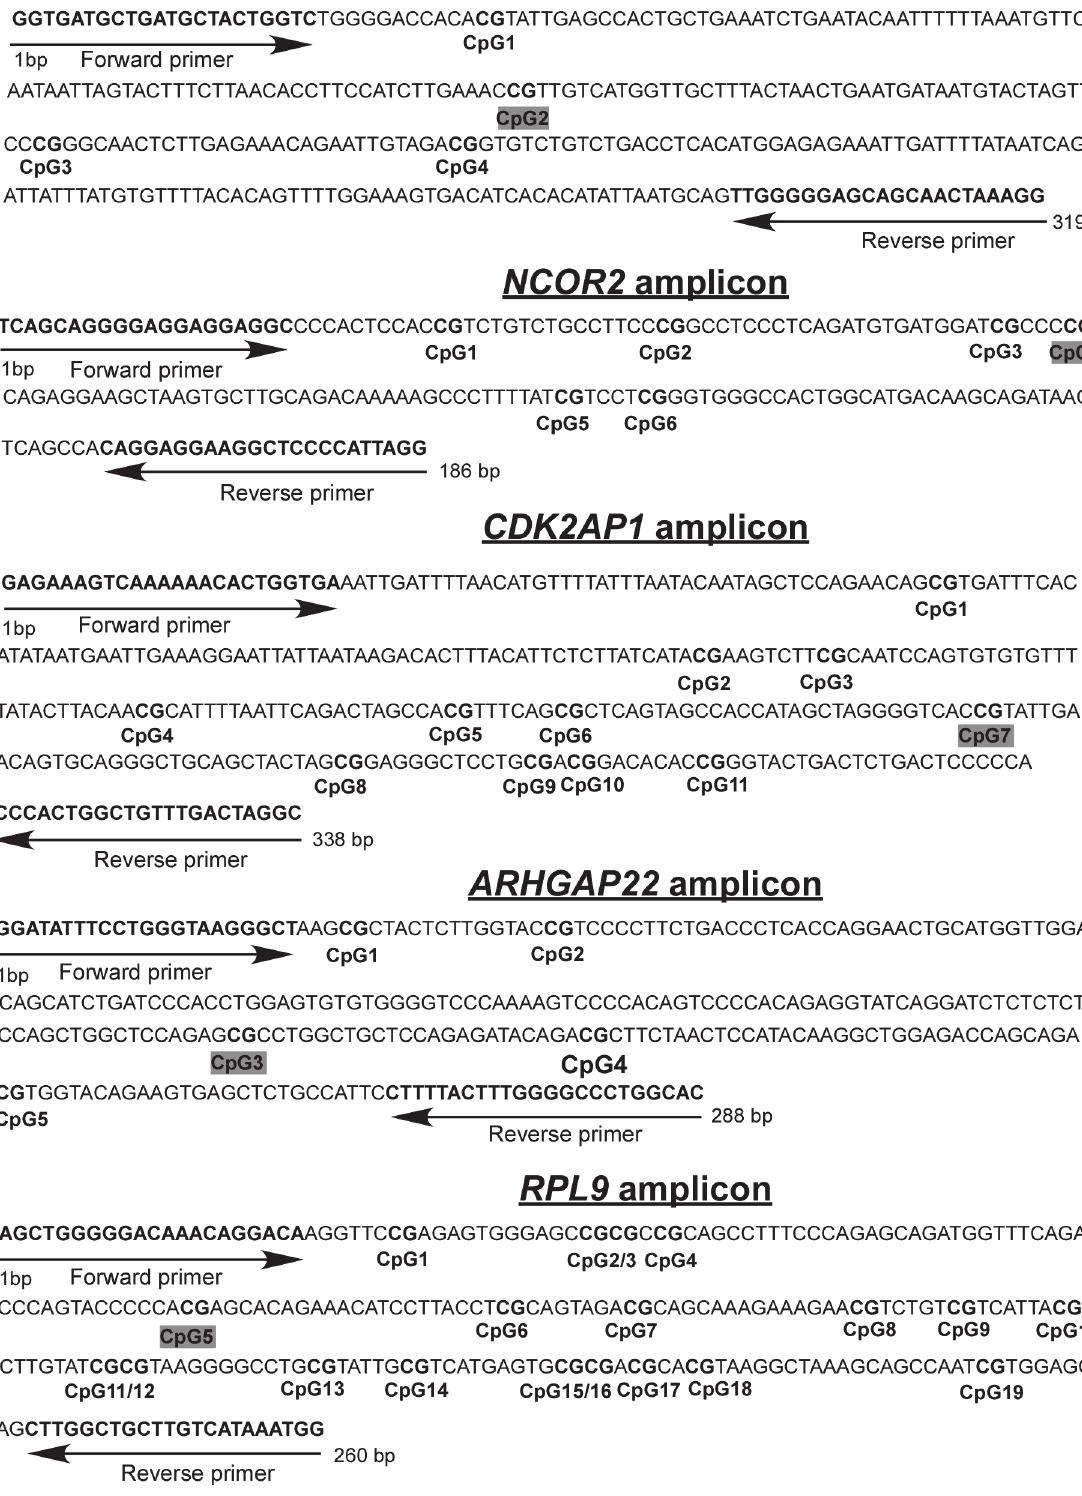
Fig 1. The sequence of analyzed amplicons with primers pairs ’ and CpG sites ’ positions. The target CpG site in each amplicon is highlighted.